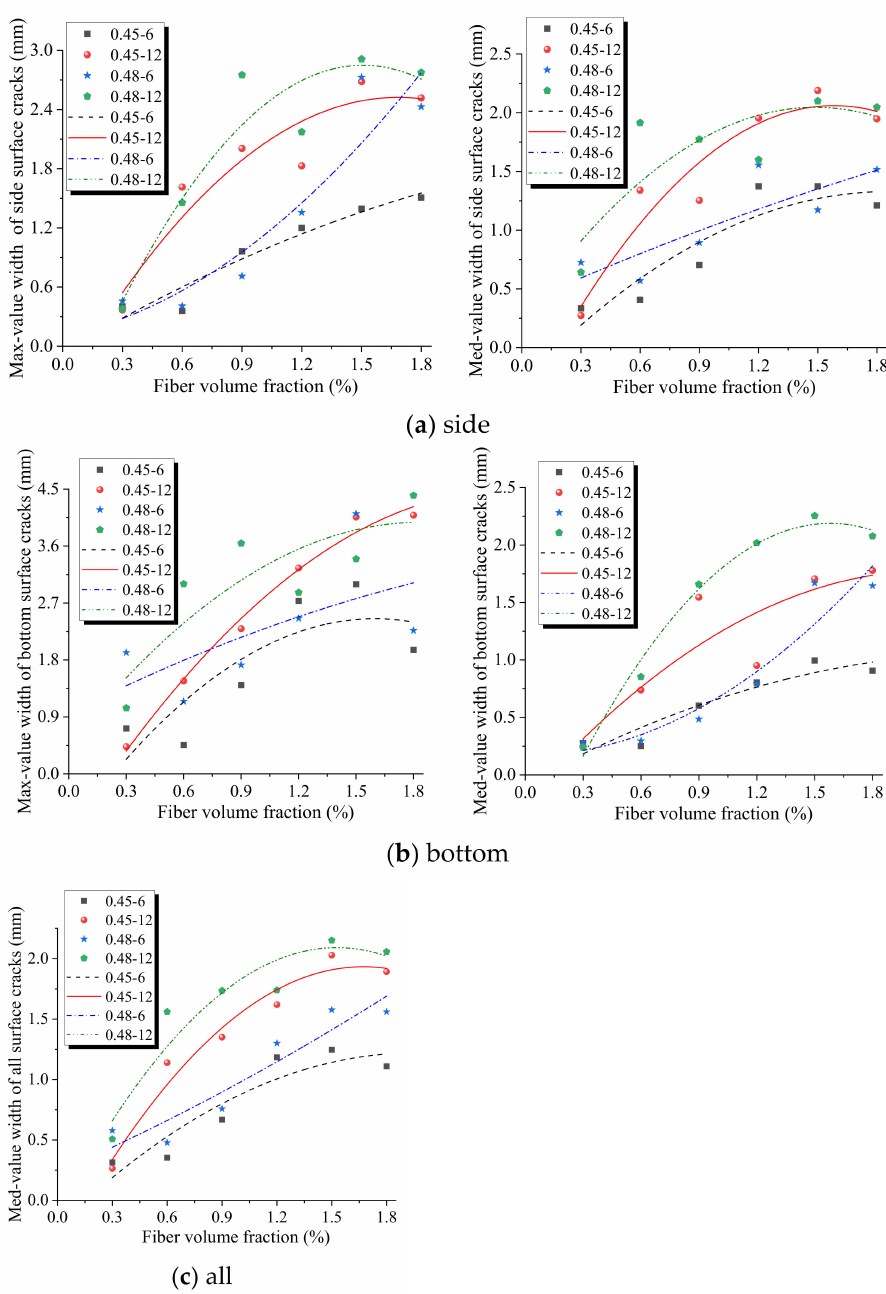
crack width indicates the better mechanical properties of the geopolymer composite. For the 0.45-12 group and 0.48-12 group, the maximum and median crack widths gradually moderated or even slightly decreased after the fiber volume fraction reached 1.5%. This is caused by the uneven dispersion when the fiber content is too large. In contrast, for the 0.45-6 group and 0.48-6 group, the maximum width of the cracks continued to increase with the fiber content. The reason is that 12 mm fibers tend to disperse unevenly and agglomerate, whereas 6 mm fibers are shorter and less likely to agglomerate. Therefore, the 6 mm fiber can continue to play a role in high content.